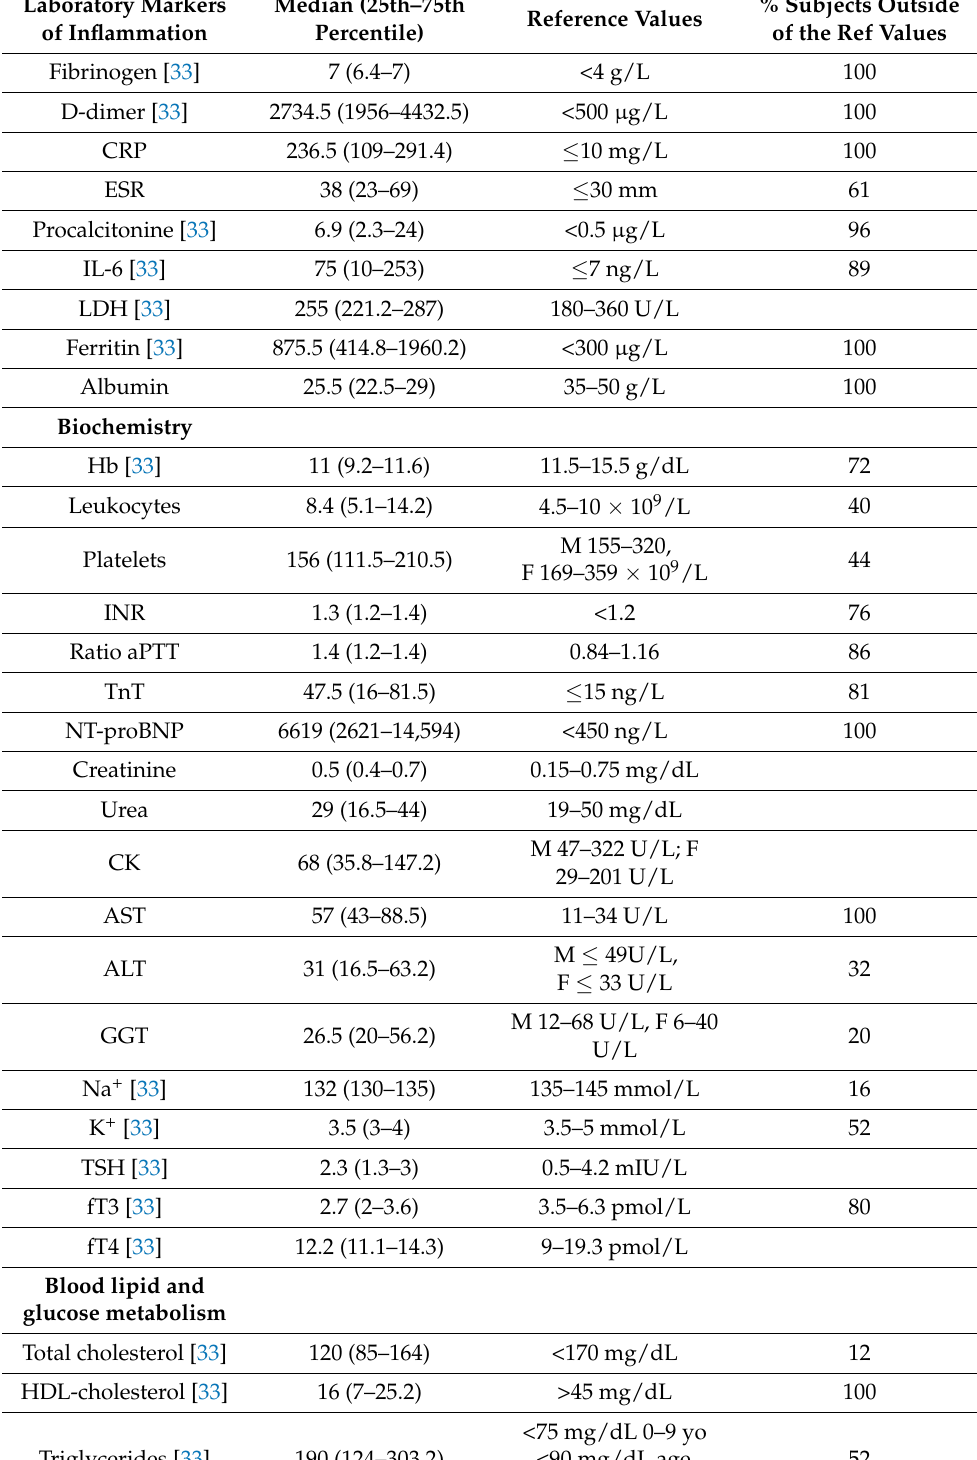
Table 2. Biochemical data of MIS-C children at hospital admission. Values are expressed as median and 25th–75th percentile. The % of subjects with values outside of the reference intervals is also